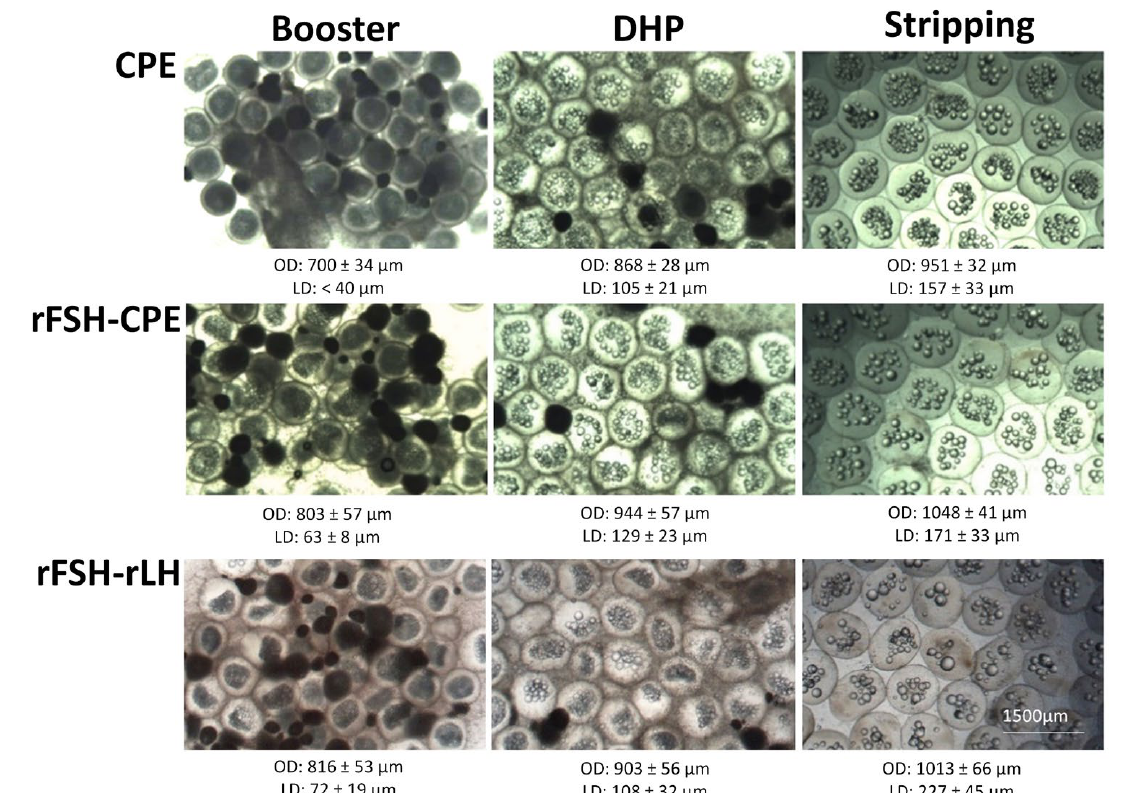
Figure 7. Oocytes of eels treated with CPE, rFSH-CPE and rFSH-rLH at the moments of booster injection, DHP injection and stripping (see Section 2 for a description of the treatment protocol). For each treatment, increases in oocyte diameter and lipid diameter were observed between the moments of DHP injection and booster injection and between stripping and DHP injection. At the bottom of each picture, the average ± standard deviation of the respective oocyte diameter (OD) and lipid diameter (LD) is given. No differences between treatments were observed.